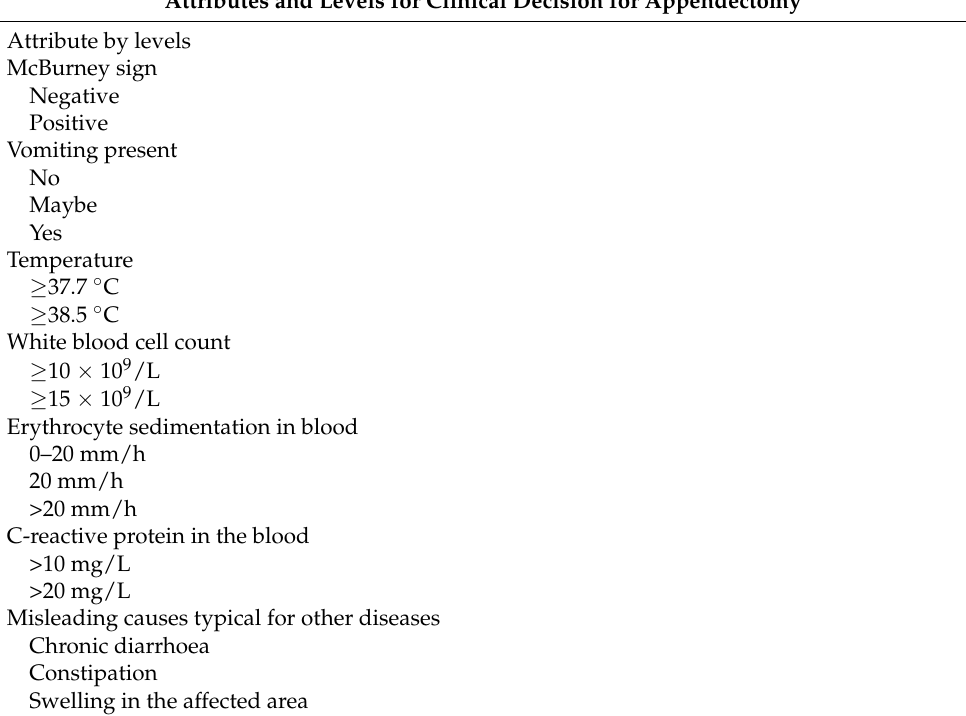
Table 1. Attributes and levels for clinical decision for appendectomy. Attributes and Levels for Clinical Decision for